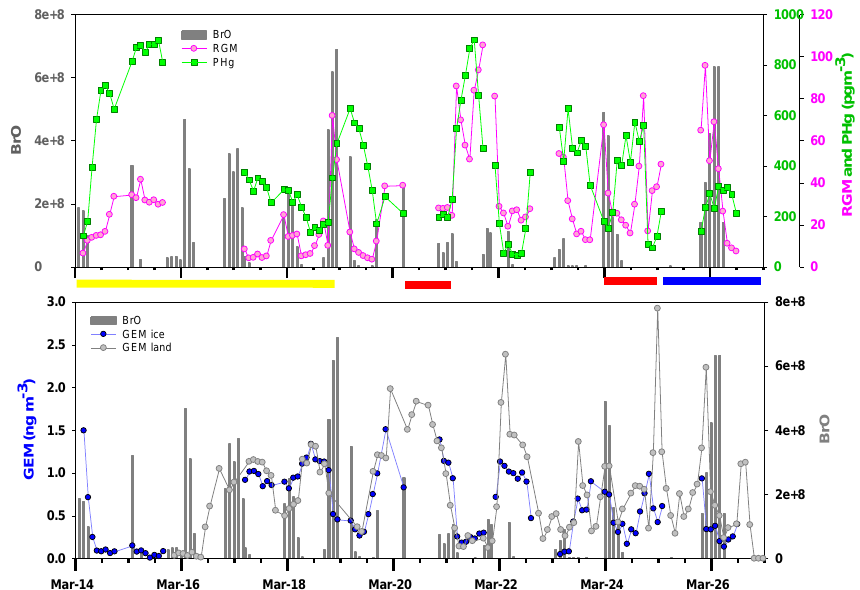
Fig. 5. BrO and PHg/RGM measurements over the sea ice and BrO and GEM measurements over both tundra and sea ice. Events 1, 2 and 3 are marked as yellow, red and blue, respectively.